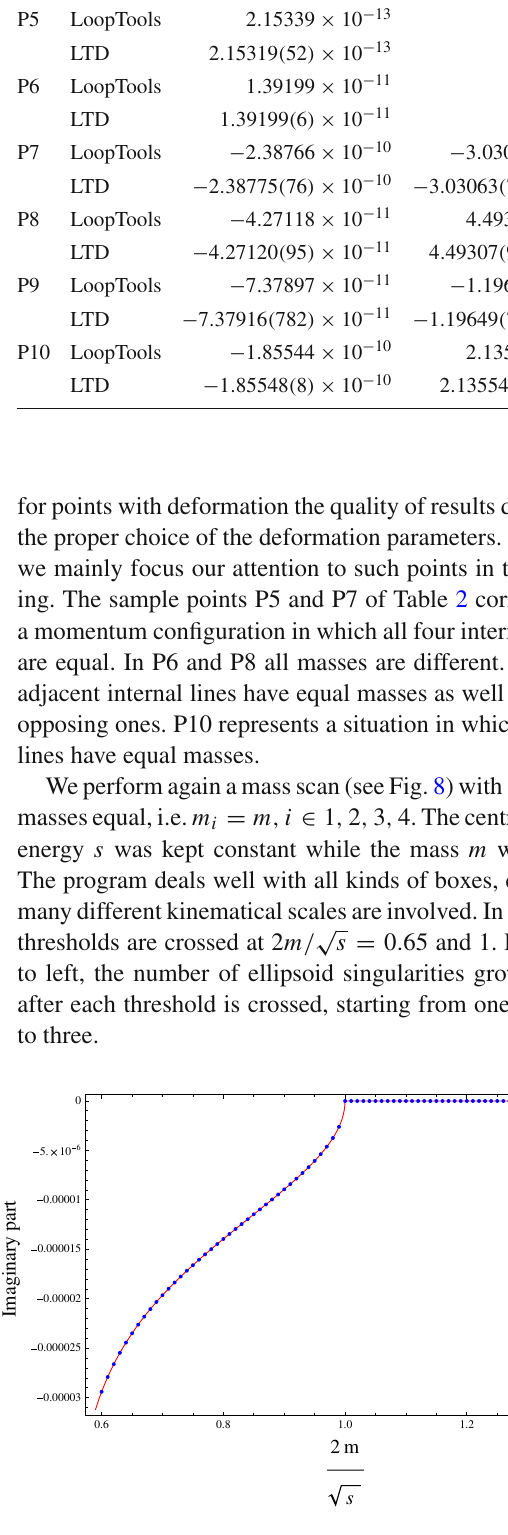
Fig. 7 Mass scan of the region around threshold. The red curve is done with LoopTools and the blue points are obtained with the LTD